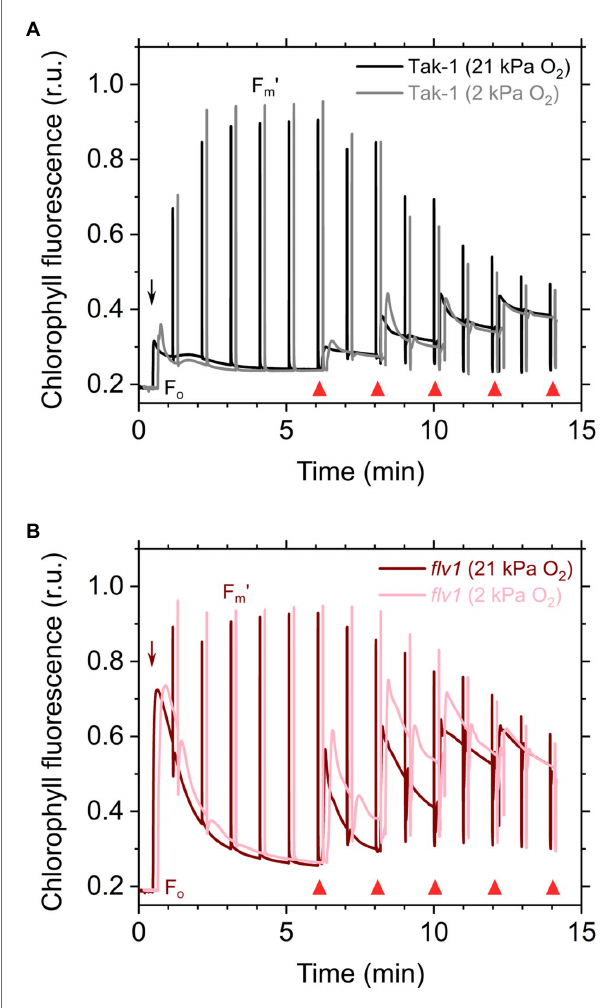
FIGURE 2 | Responses of chlorophyll fluorescence to the light in the liverwort M. polymorpha (Tak-1; A ) and the mutant flv1 (B) . Experiments were performed under 21 (darker lines) and 2 kPa O 2 (lighter lines). Fluorescence measuring light was illuminated to determine the minimum fluorescence from dark-adapted thalli (F o ). Short-saturation flashes were applied every 1 min to determine the maximum fluorescence from light- adapted thalli (F m ' ). Red actinic light was turned on at the time indicated by black arrows, and the light intensities were changed as indicated by red triangles (50, 100, 200, 390, and 760 μ mol photons m − 2 s − 1 ). Relative chlorophyll fluorescence intensity is normalized by the maximum fluorescence from a dark-adapted thalli (F m ). Measurements were conducted independently three times (biological replicates), and representative traces are